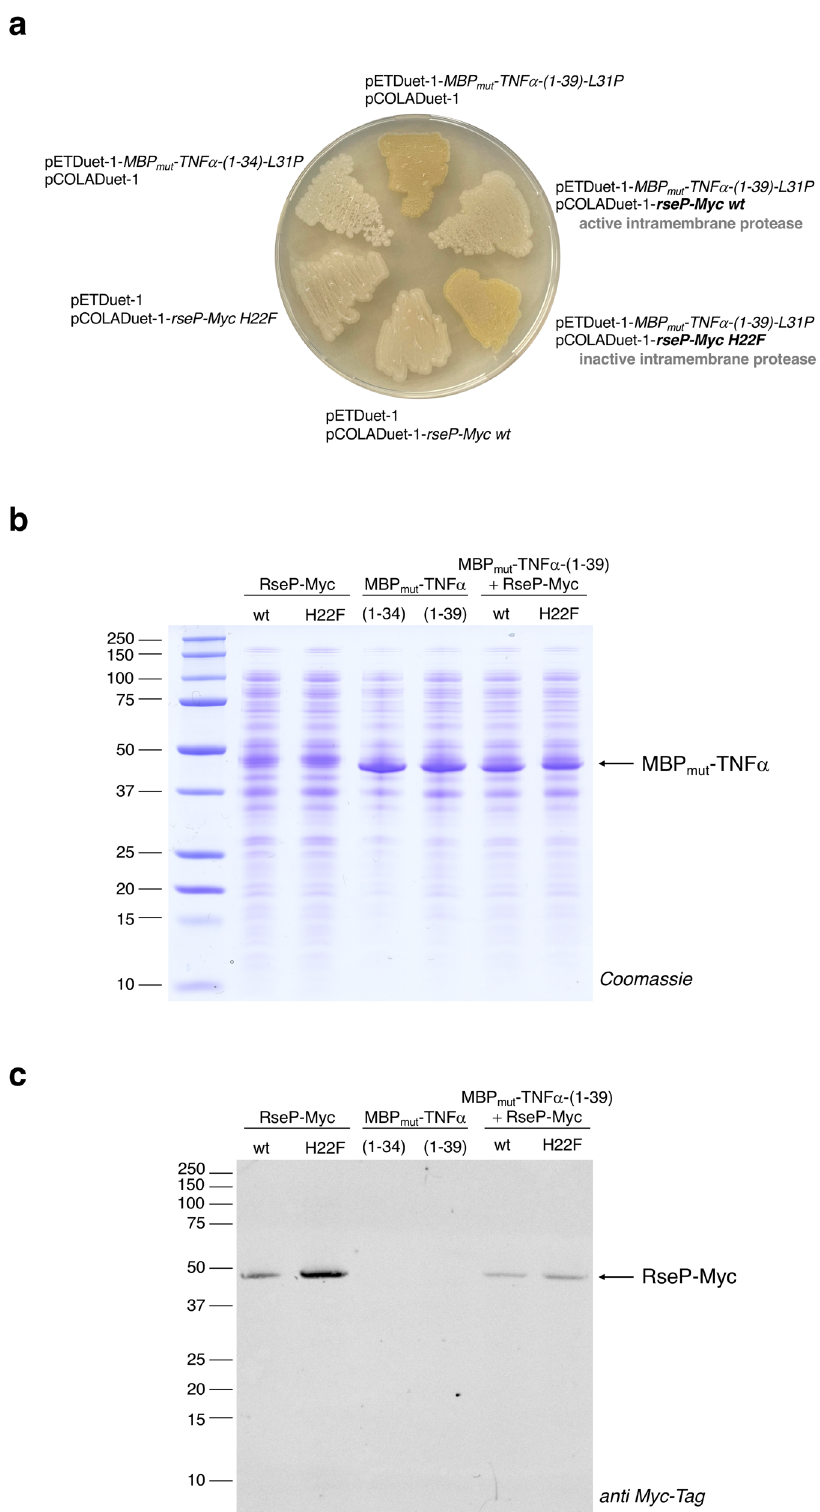
L31P fusion proteins (Fig. 4d). Heme-free monomers are always present as heme is not stoichiometrically bound by TNF α -ICDs 25 . The higher content of heme-free monomers of MBP mut -TNF α - L31P in the case of RseP wt compared to RseP H22F is probably related to a lower heme binding af fi nity of the processed fusion protein (compare UV/Vis spectra in Fig. 4c), because hydro- phobic residues within the heme-binding motif SRRCPFLSLFSFL